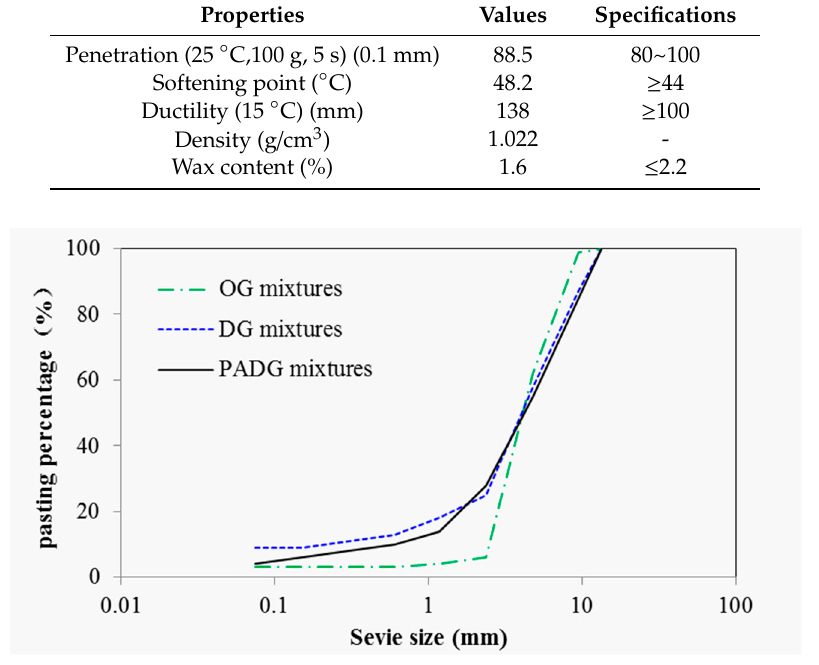
Figure 5. Gradations of DG mixtures, open graded (OG) mixtures and PADG mixtures.